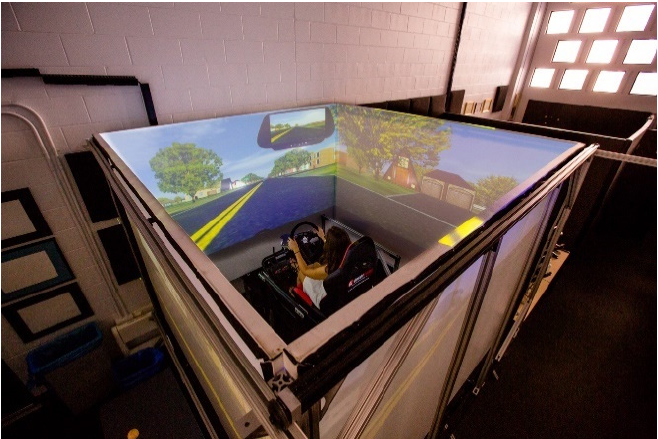
Figure 2. Fixed-base simulator.